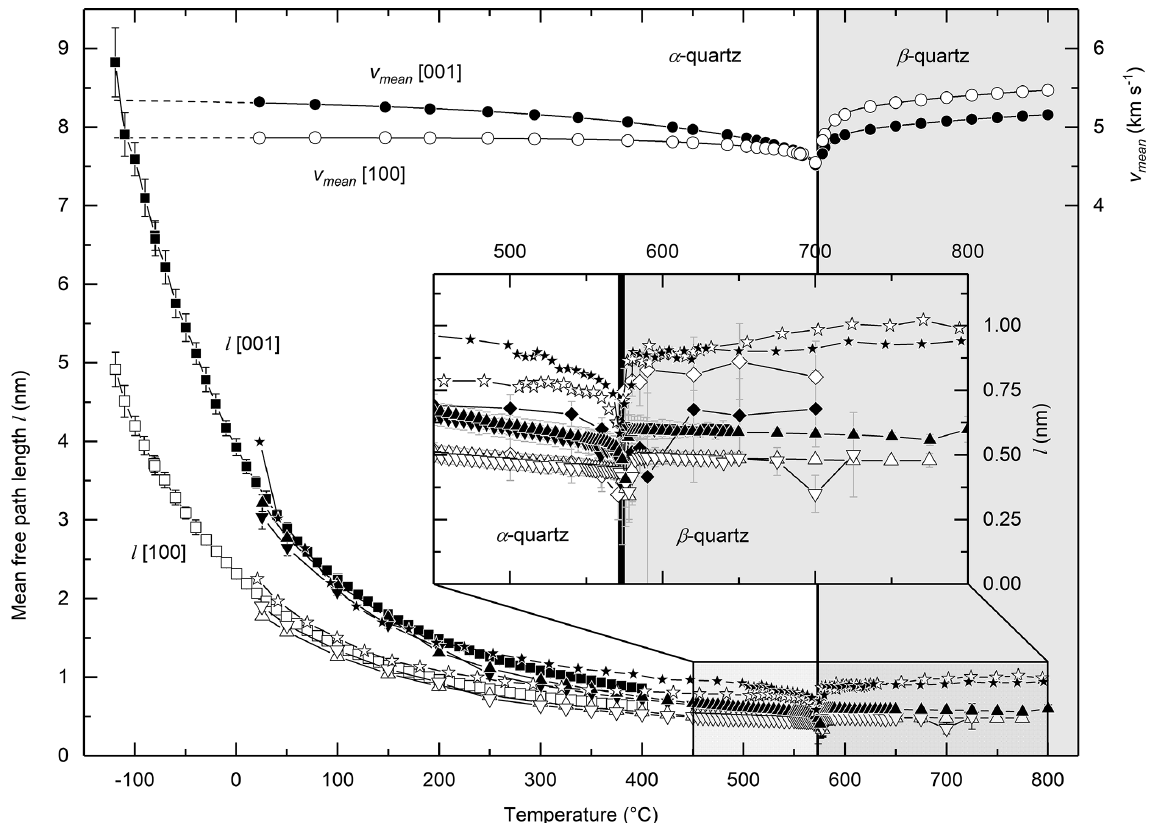
Figure 5. Phononic mean free path length l between − 120 and 800 ◦ C for the [001] (black filling) and [100] directions (white filling) and different specimens: LT (squares), HT1 (upwards triangles) and HT2 (downwards triangles). Calculated after Eq. (4) with v mean (circles) derived from elastic constants given by Kammer et al. (1948); Zubov and Firsova (1962); Ohno (1995). Averaged sound velocities are extrapolated to − 120 ◦ C (dashed black line). Data given by Höfer and Schilling (2002) are shown as stars for comparison. The mean free path length l of the thick cubic specimen (this study; see Fig. 4a) is given as diamonds